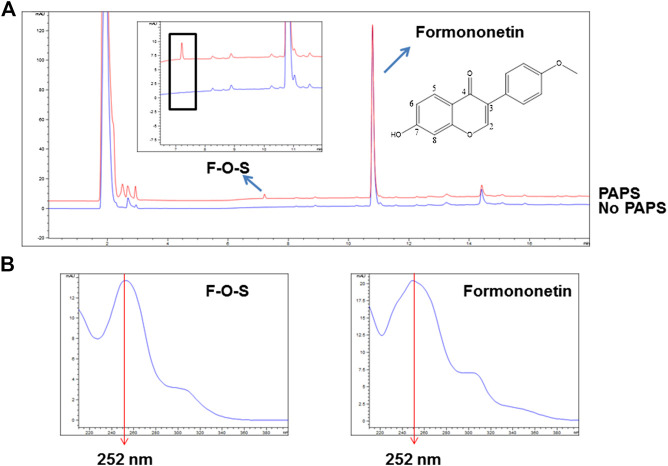

(A) Chemical structure of formononetin and representative HPLC chromatograms for quantitative analyses of formononetin and its sulfate (F-O-S). (B) UV absorption spectra of formononetin and F-O-S.